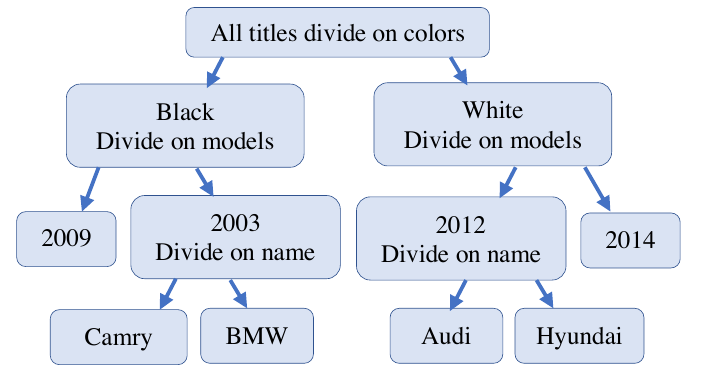
Fig. 2. A random decision tree with vertically partitioning